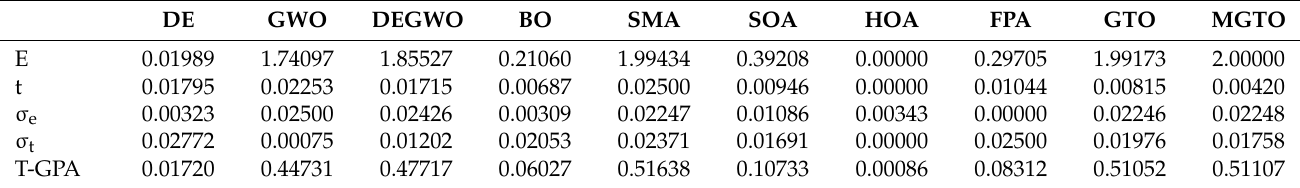
Table 10. Comparison under GPA on test case 2.